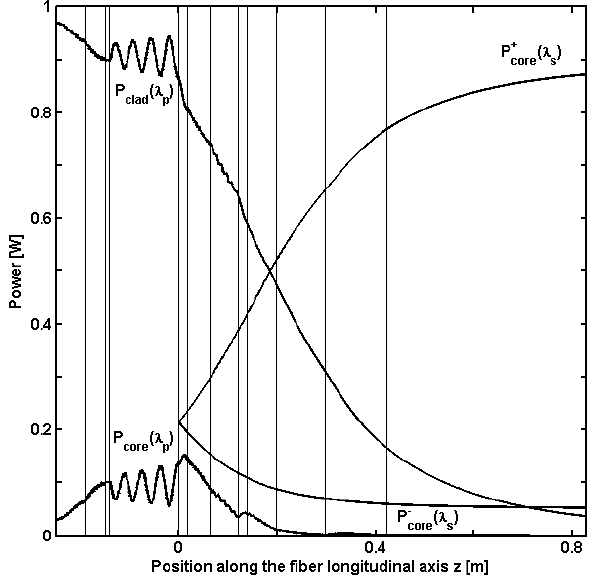
Figure 14. Power P longitudinal axis z , DS-MLPGs